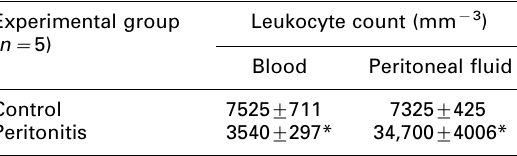
Table 1. Effect of experimental peritonitis on leukocytes count in blood and peritoneal fluid Experimental group (n (cid:5) /